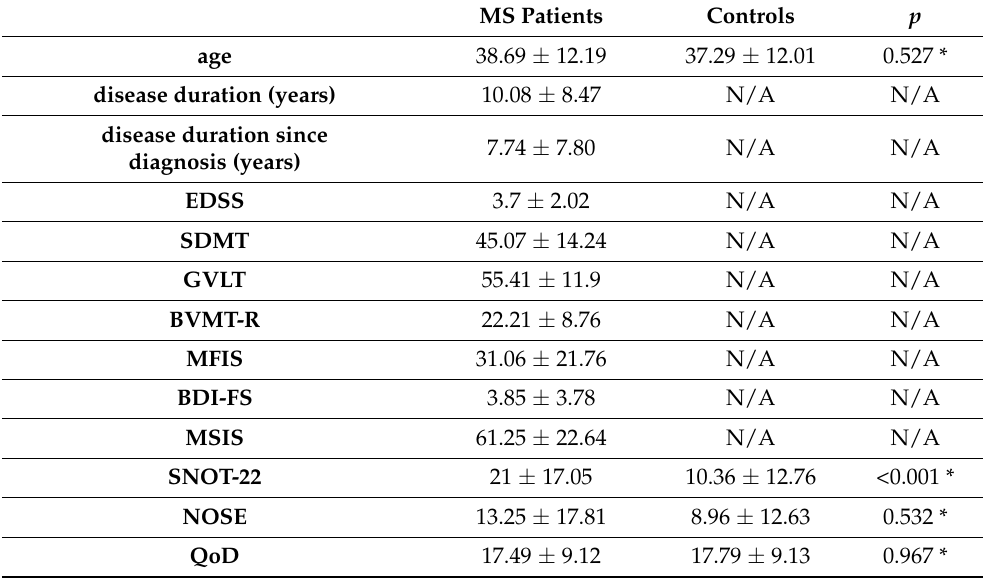
Table 1. Demographic and clinical data of the participants.